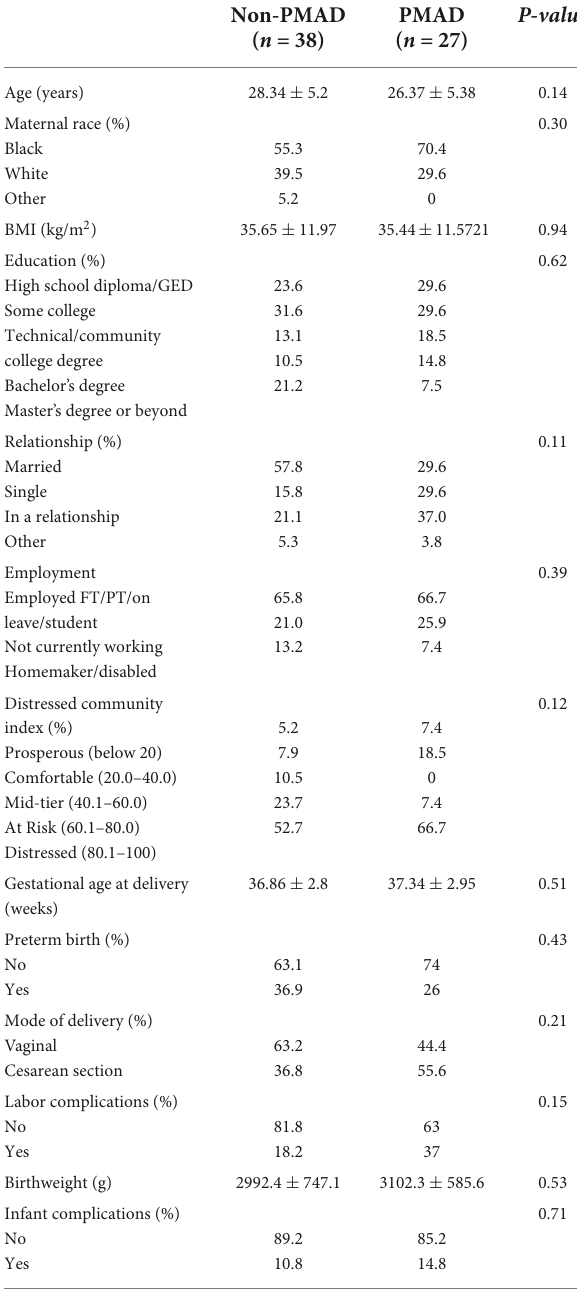
TABLE 4 Sociodemographic and labor characteristics between women with and without perinatal mood and anxiety disorders